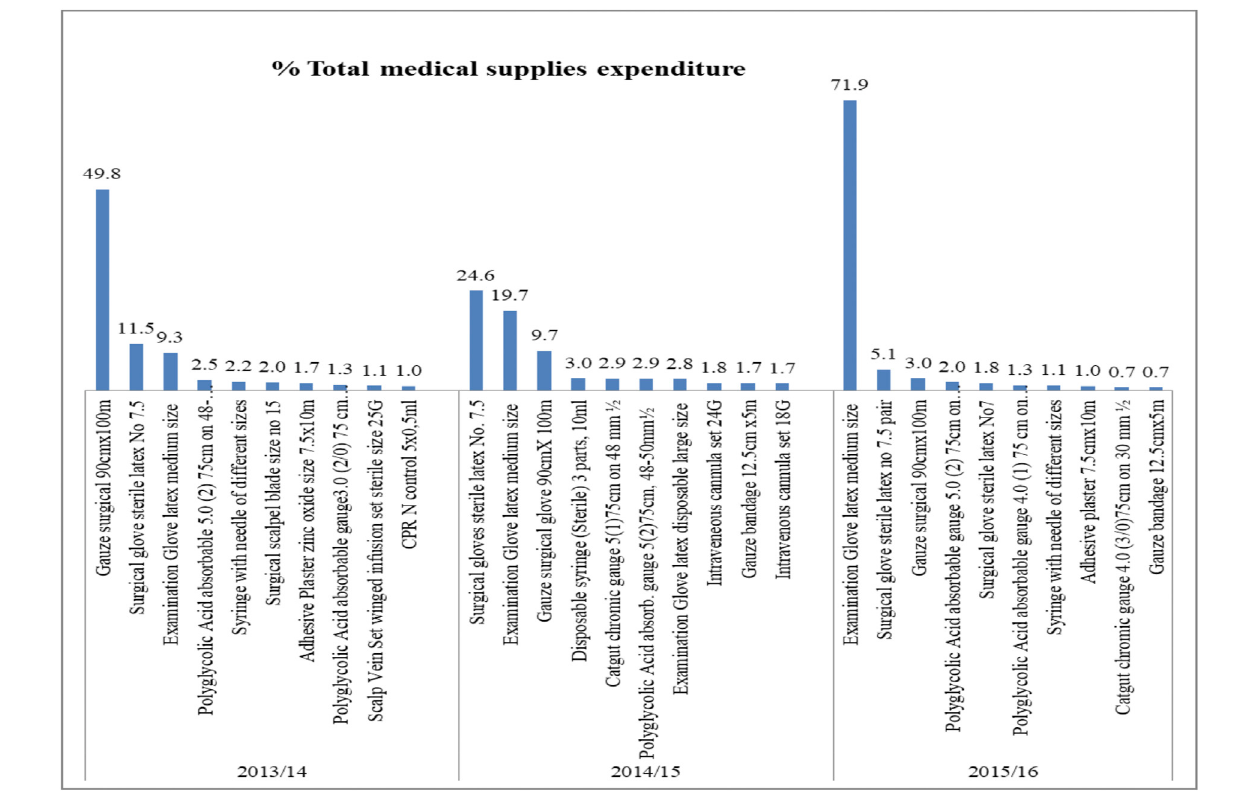
TABLE 7 | Morbidity pattern at SPHMMC for 2014/15-2015/16.